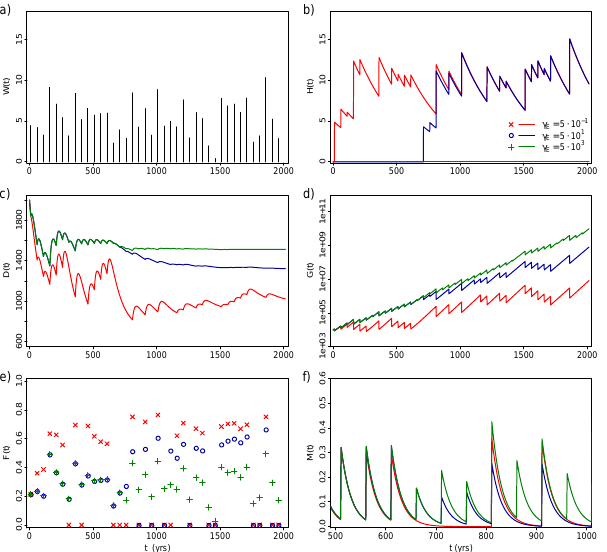
Fig. 5. The evolution of WetTown assuming a slow decay of pro- tection levels (i.e. κ T = 3 × 10 − 4 yr − 1 ): (a) high water levels [m]; (b) flood protection levels [m]; (c) distance of WetTown from Wild- Waters River [m]; (d) size/wealth of WetTown [m 2 ]; (e) relative flood damages [.]; (f) awareness of the risk of flooding [.]. The colour of lines and points refers to the three scenarios: low-cost (red), moderate-cost (blue) and high-cost (green).